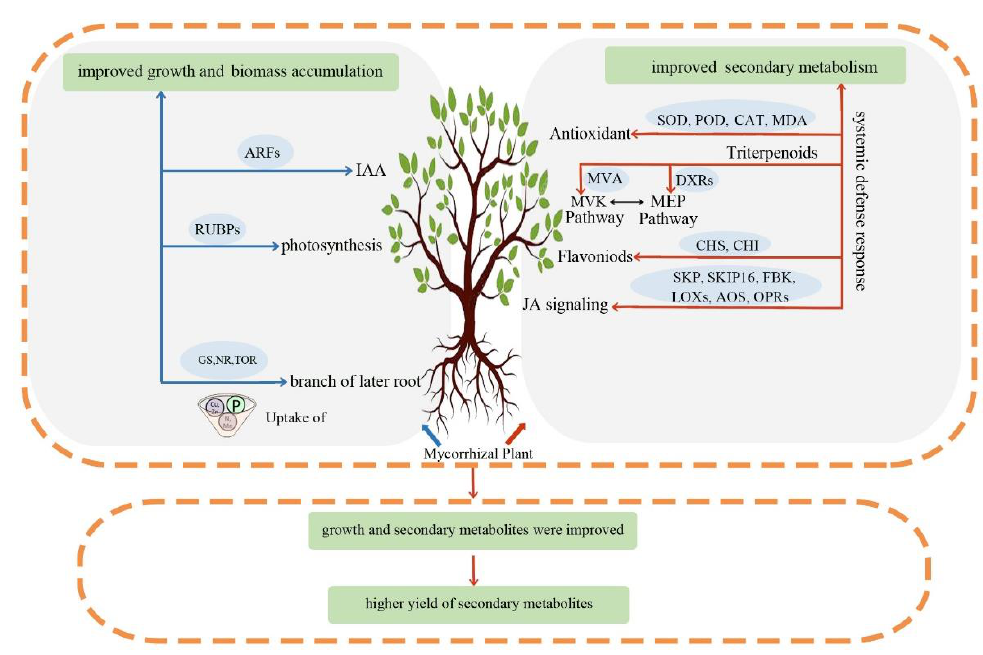
Figure 6. Proposed working model of the role of mycorrhizal fungal in the regulation of growth and secondary metabolites in C. paliurus.